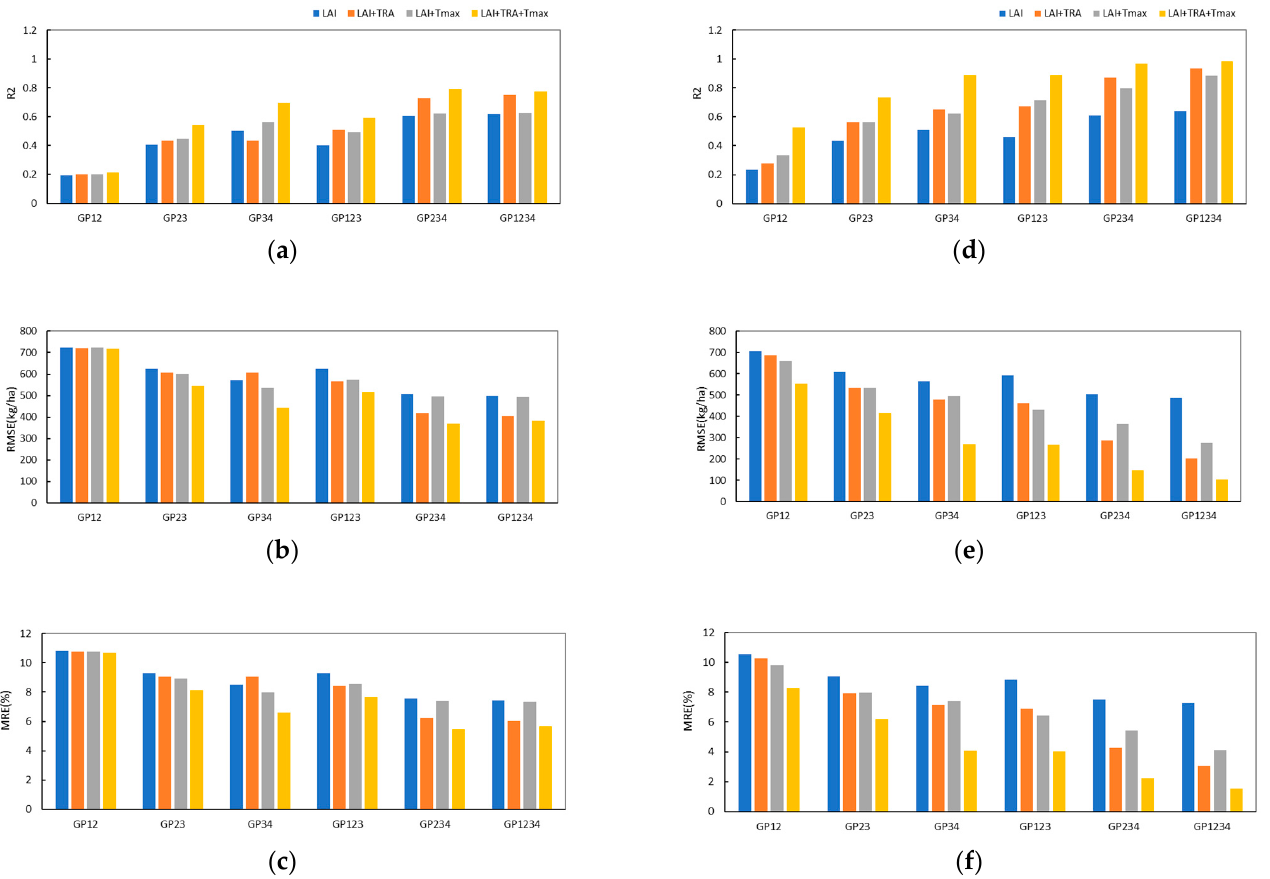
Figure 9. Performance of RF and GRU models at each predicted event. ( a ) The R 2 of the RF model in every forecast event; ( b ) The RMSE of the RF model in every forecast event; ( c ) The MRE of the RF model in every forecast event; ( d ) The R 2 of the GRU model in every forecast event; ( e ) The RMSE of the GRU model in every forecast event; ( f ) The MRE of the GRU model in every forecast event.